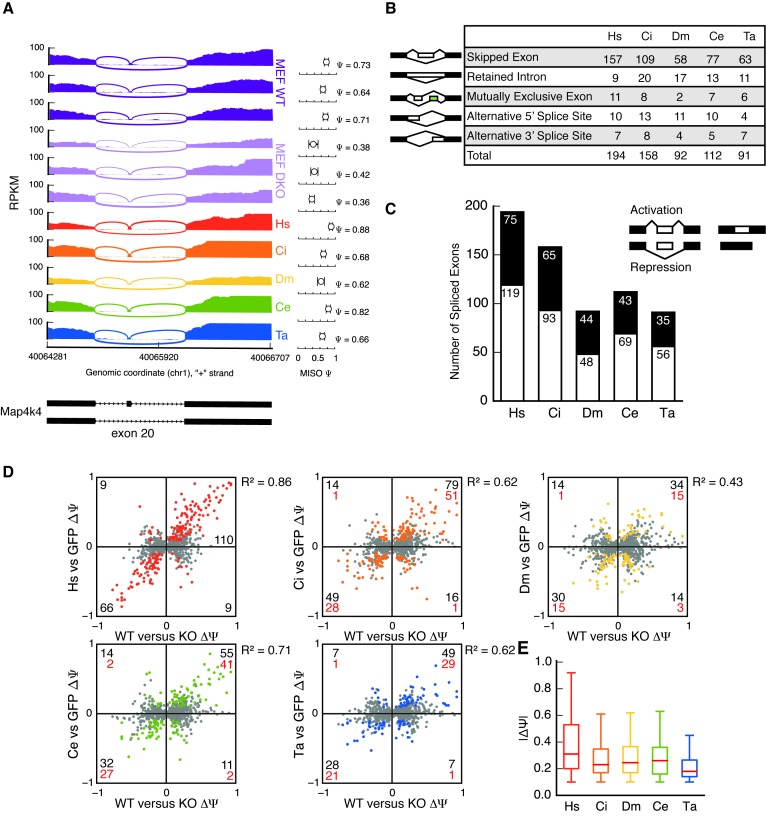
Distant MBL homologs regulate splicing of many endogenous exons in a manner similar to human MBNL1. (A) RNAseq read coverage across Map4k4 exon 20 shows an example of alternative splicing regulation in WT, DKO and MBL-reconstituted MEFs. MISO Ψ values and 95% CIs are shown at right. (B) All types of alternative splicing are regulated by MBL homologs. (C) Number of spliced exons activated (white bar) or repressed (black bar) by MBL homologs. Hs and Ce show significantly more splicing activation than repression. (D) Reconstitution of MBL homologs rescues splicing in MBNL1/2 DKO MEFs. Exons significantly regulated in WT MEFs: gray points; exons significantly regulated in reconstituted cell lines: red (Hs), orange (Ci), yellow (Dm), green (Ce), blue (Ta) points. Black numbers in quadrants show the number of exons significantly regulated in reconstituted cells. Red numbers show the number of exons significantly regulated by both HsMBNL1 and associated MBL homolog. (E) Boxplot of absolute splicing changes, |ΔΨ|, for colored points in (D) shows that HsMBNL1 exhibits the strongest splicing regulation, whereas TaMBL exhibits the weakest.